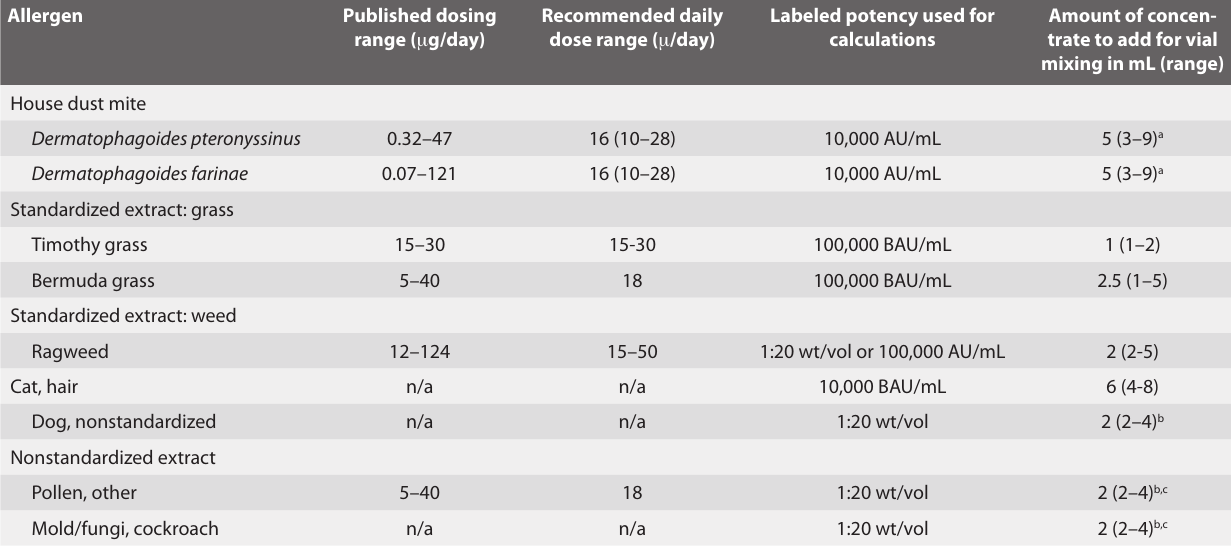
Table 2. Recommended SLIT-D dosing (10-mL treatment vial). Reproduced with permission from Leatherman et al., 2015 (13) .